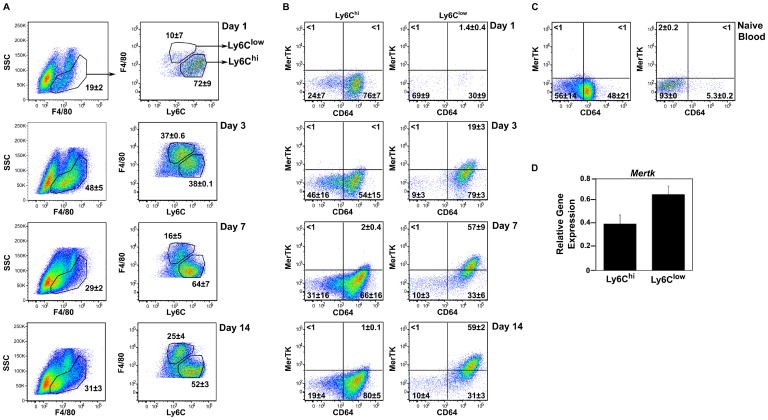
Phenotype of wound monocyte/macrophage subsets.C57BL/6J mice were wounded for 1, 3, 7 or 14 days. Wound cells were isolated and examined by flow cytometry. FSC and SSC were used to gate viable cells. (A) Wound monocytes/macrophages were defined as F4/80+SSClow/int. F4/80intSSChi eosinophils were excluded from analysis. Gated F4/80+ wound monocytes/macrophages were additionally examined for expression of Ly6C. (B) Expression of CD64 and MerTK was examined on gated Ly6Chi and Ly6Clow monocyte/macrophage subsets. (C) Blood cells were isolated from naïve C57BL/6J mice and examined by flow cytometry. An identical gating strategy to that described for wound cells was employed to examine MerTK and CD64 expression on blood F4/80+Ly6Chi and Ly6Clow monocytes. Numbers accompanying gates are the mean ± SD, n = 3 mice per group, and are representative of 2–3 independent experiments. (D) Mertk gene expression was determined in day 14 Ly6Chi and Ly6Clow wound monocyte/macrophage subsets by qPCR. Mertk expression was normalized to Hprt and data are presented as ΔCt Expression. Data shown are the mean ± SD, n = 3 mice per group.